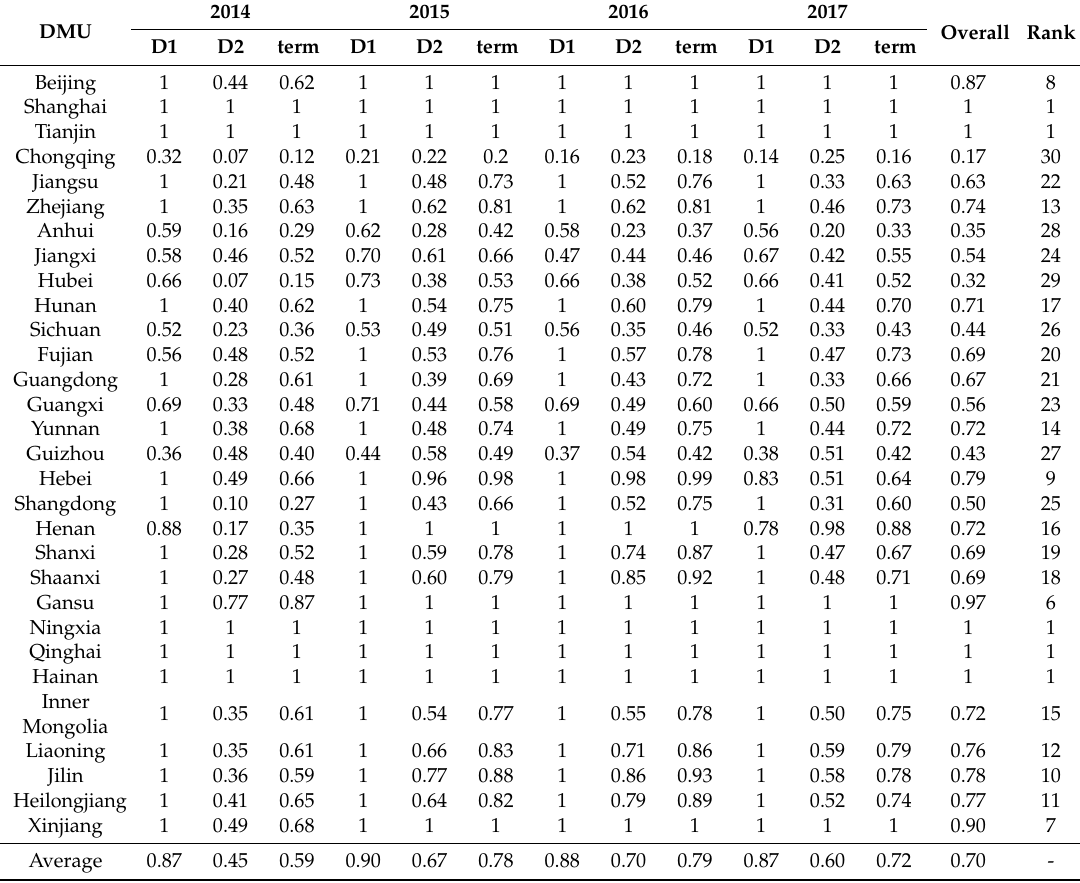
Table 4. Energy using efficiency and environmental performance of China provincial